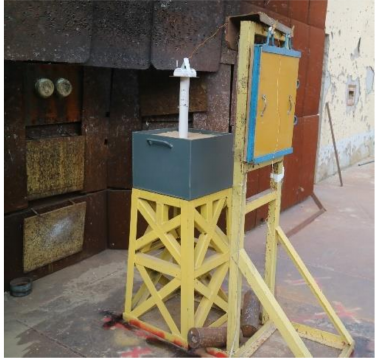
Figure 3. Flash X-ray experimental setup diagram.